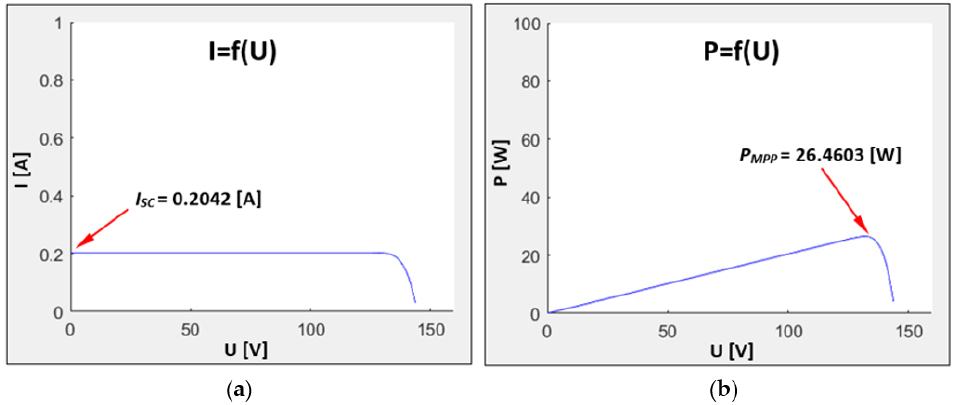
Figure 8. Simulation results for irradiance of 300 W/m 2 deflected by an angle Δ θ = 4° from the di- rection of perpendicular incidence and a temperature of 21 °C for the modeled CX-75/200 module: